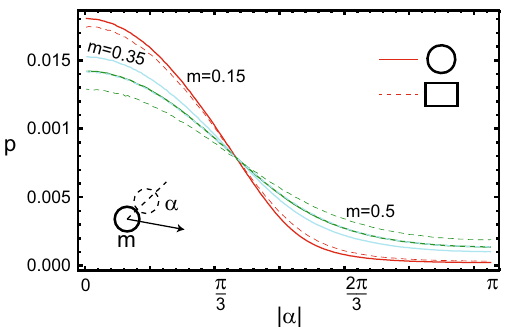
Figure 3. Distributions of collision angles for three particles with masses ( m : 0.15, 0.35, 0.5) in a round vessel. For comparison, dotted lines show similar dependencies for a rectangular vessel. It is visible that in a round vessel, the share of frontal collisions with small m 0.5 in round vessels 3 =